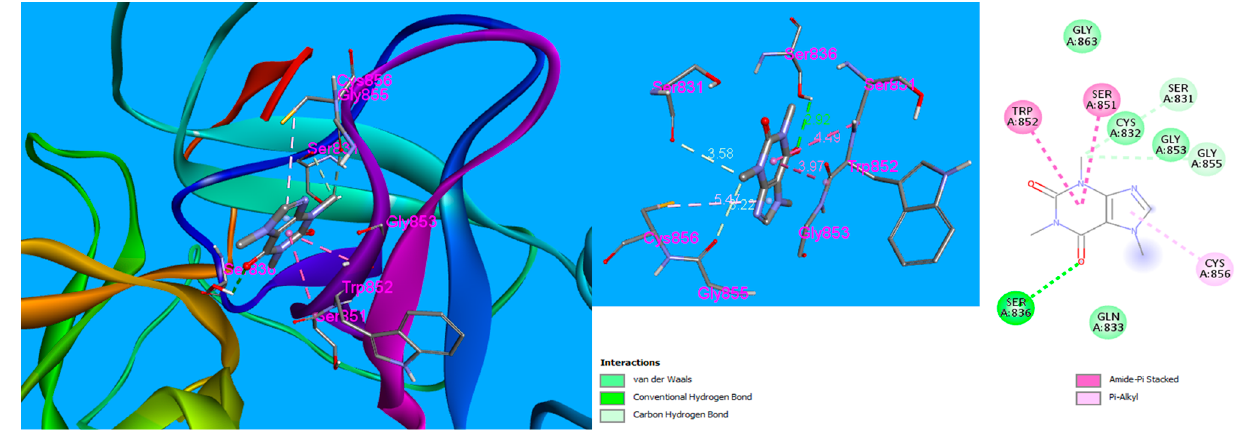
Figure 12. Molecular docking interaction of 2 on protease enzyme.